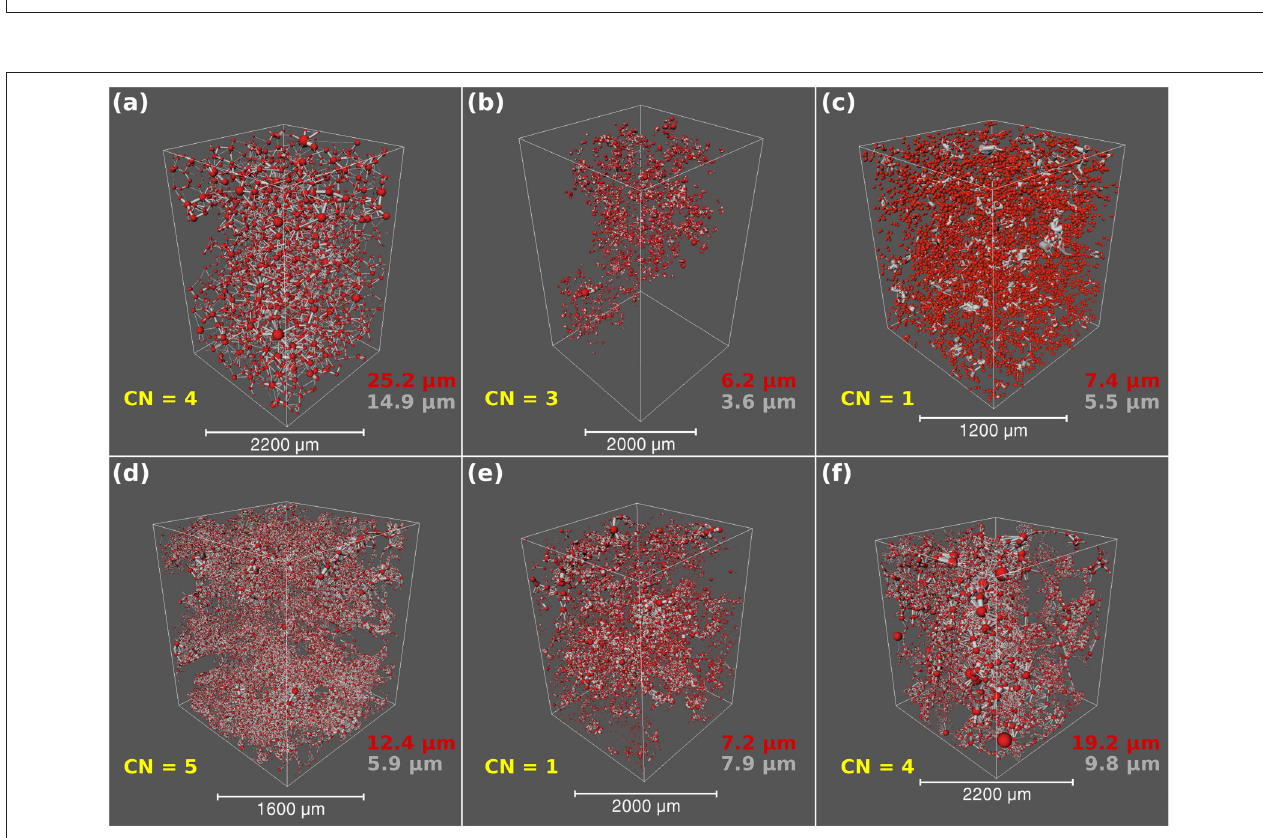
FIGURE 4 | Pore network model visualization of the six samples using the macroporosity network only. From top, left to right: (a) Doddington sandstone, (b) Knorringfjellet sandstone, (c) Wilcox sandstone, (d) Estaillades limestone, (e) Massangis Jaune limestone, and (f) Savonnières limestone. In this schematic the pores are displayed as red spheres and the throats are gray cylinders. CN = mean coordination number, whilst the red text represents the median pore radius and the gray text represents the median throat radius.